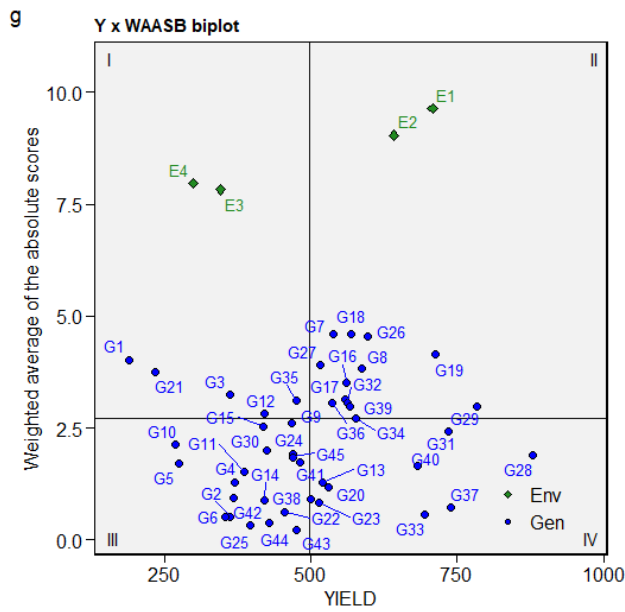
Figure 4. Biplot of the seed yield (kg/ha) and weighted average of the absolute scores.